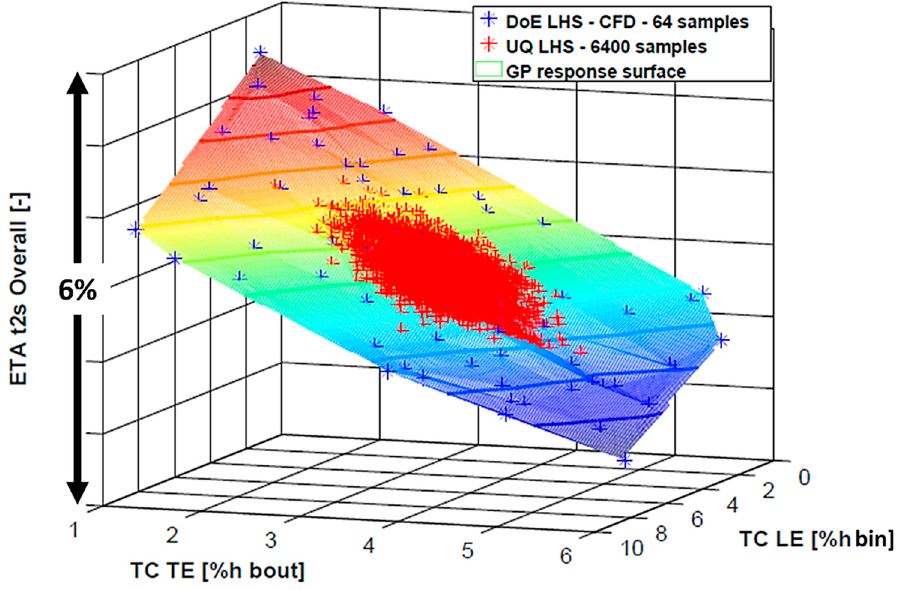
Figure 5. SB-UQ: overall efficiency response surface and samples.